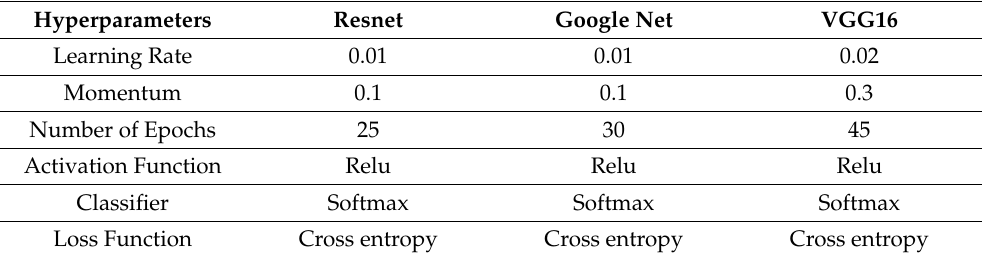
Table 3 lists the optimized hyperparameters obtained using grid search optimization of the three models. Table 3. Optimized hyperparameters for the three